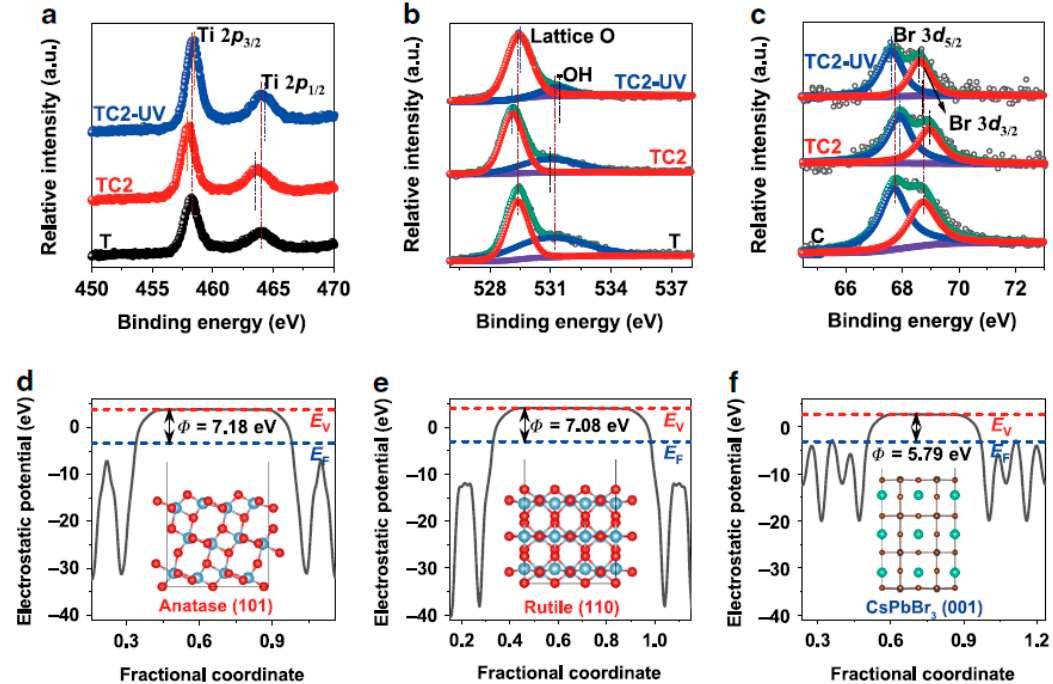
Figure 5. ( a − c ) Ex-situ and in-situ XPS of TiO 2 (T) and TiO 2 / CsPbBr 3 (TC2) samples (TC2-UV is in-situ XPS under UV light irradiation), and electrostatic potentials for ( d ) anatase TiO 2 (101), ( e ) rutile TiO 2 (110) and ( f ) CsPbBr 3 (001) facets. Reproduced from [79], with permission from Springer Nature, 2020.